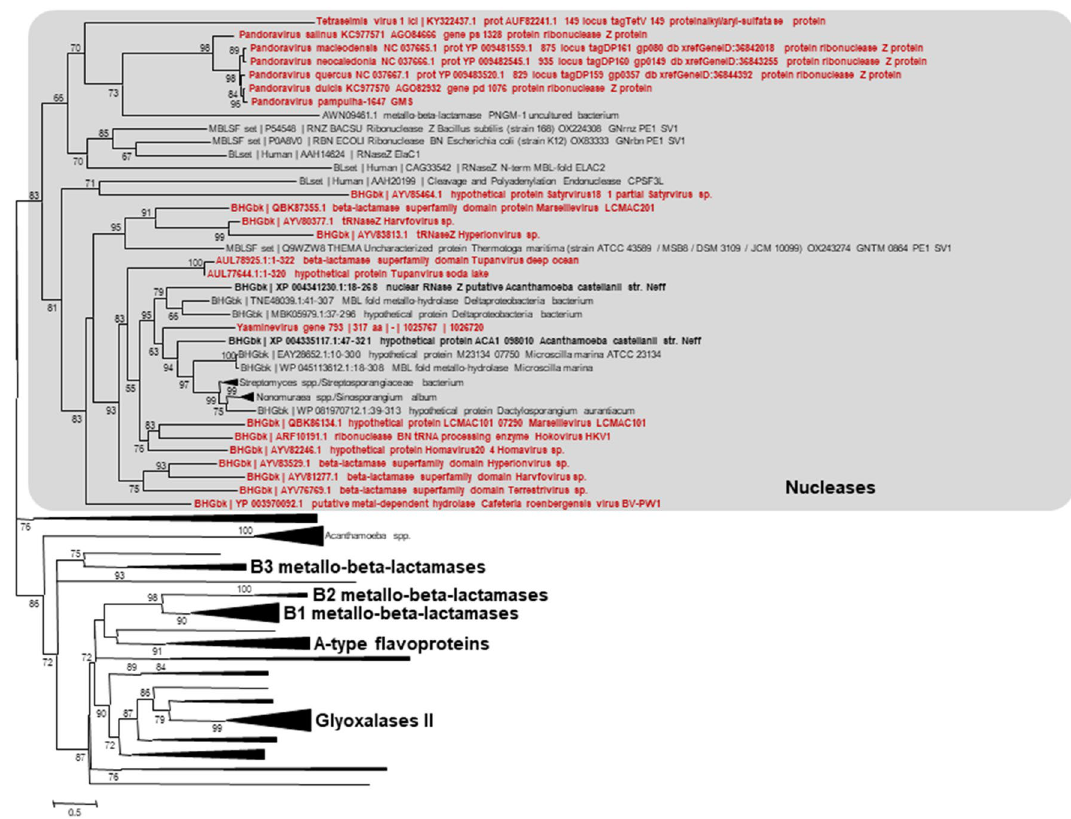
Figure 1. Phylogeny reconstruction based on metallo-beta-lactamase (MBL) fold proteins. Phylogeny reconstruction was performed after amino acid sequence alignment with the Muscle program 34 with the Maximum-Likelihood method using FastTree 35 , and tree was visualized with the MEGA 6 software 36 . The amino acid sequences analyzed are Tupanvirus deep ocean protein AUL78925.1 and its homologs with the greatest BLASTp scores from the NCBI GenBank protein sequence database (nr) (see Supplementary Table 1), our sequence database of giant virus genomes, and previously described draft genome sequences from 14 Acanthamoeba species 37 ; a set of previously described MBL fold proteins 21 ; and a set of sequences from the UniProtKB database 1 , previously used for phylogeny reconstructions. Extended tree is available in Supplementary Fig.